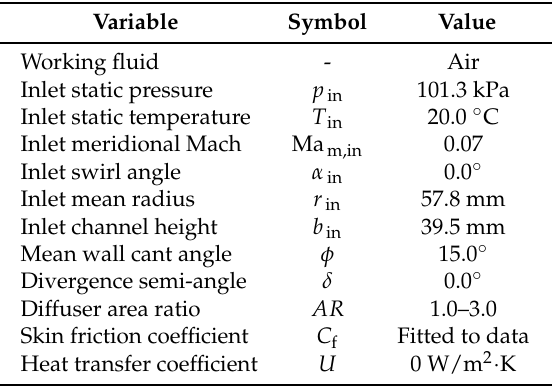
Table 4. Definition of the validation case from Kumar and Kumar [30].